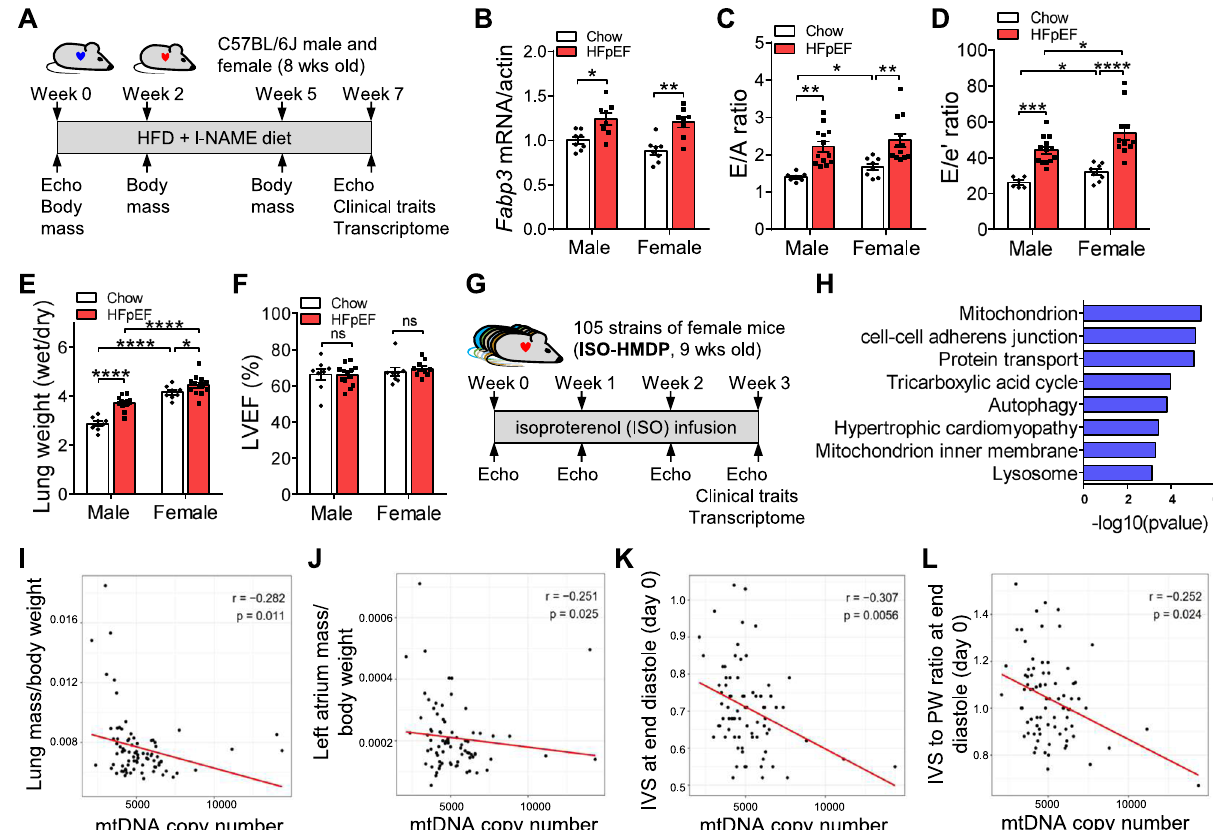
Fig. 1 Sex-biased diastolic dysfunction in the progress to HFpEF and mtDNA level was associated with diastolic function. A Experimental timeline for the development of HFpEF in C57BL/6J mice (8 weeks old). B Fabp3 mRNA level in C57BL/6 J male and female heart after 7 weeks of HFD +